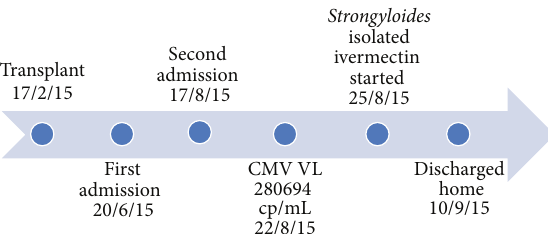
Figure 1: Timeline of the patient’s events.